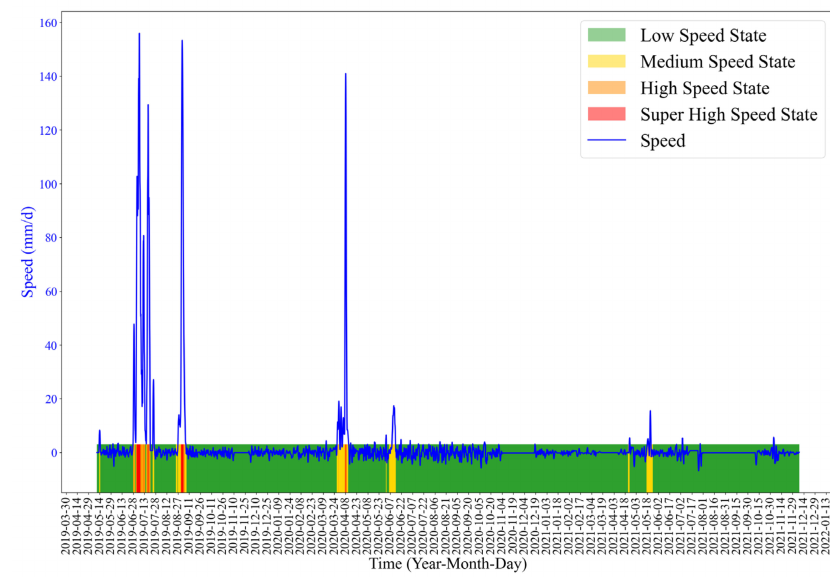
Figure 17. ResNet warning results of the Shangmao